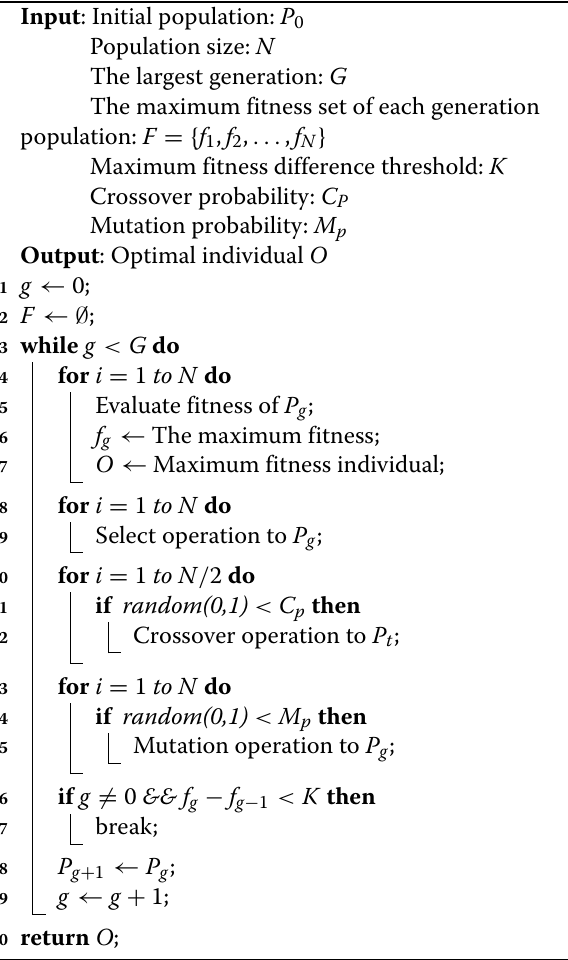
Algorithm 2: Genetic Algorithm Based Distributed Offloading